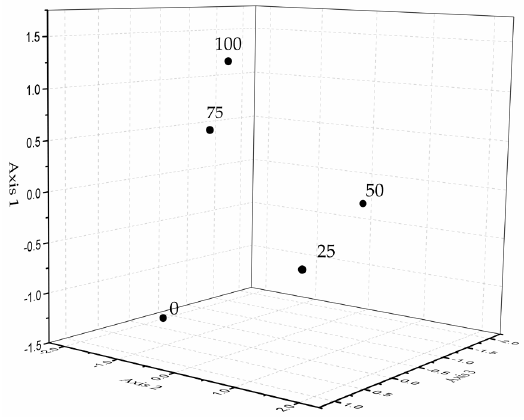
Figure 5. Relative position of five salt treatments (0, 25, 50, 75, 100 mM NaCl) in the space defined by three principle components.